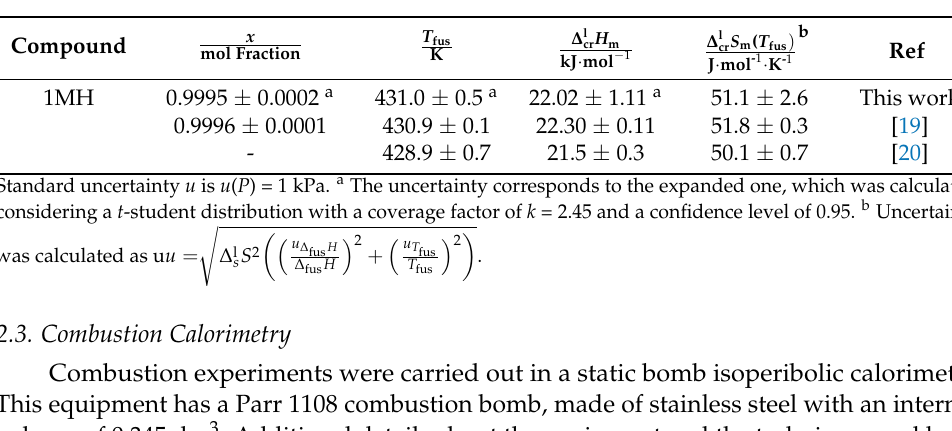
Table 2. Physicochemical properties of 1-methylhydantoin at P ◦ = 0.1 MPa obtained by DSC in this work and others reported in the